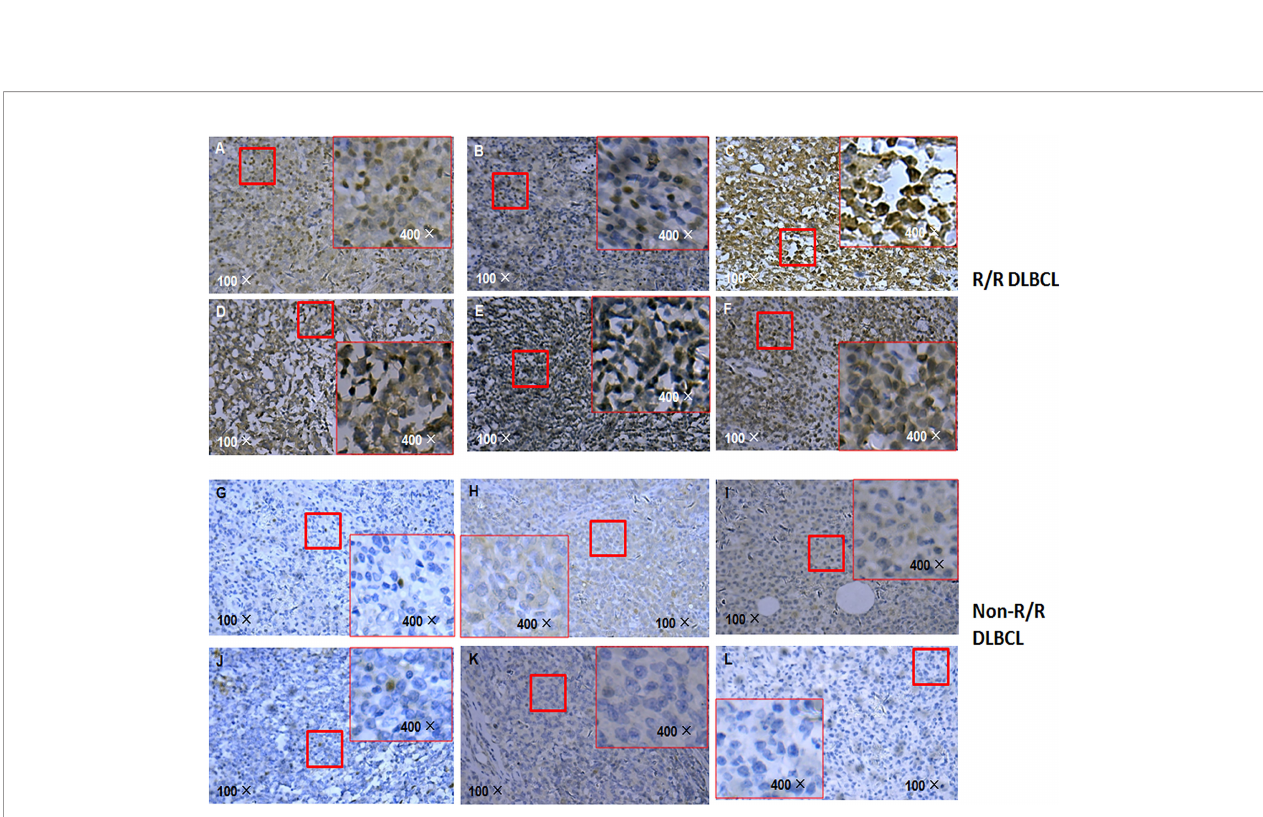
FIGURE 5 | APOBEC3B expression in R/R DLBCL and non-R/R DLBCL samples detected by immunohistochemistry. (A – F) R/R samples. (G – L) Non-R/R